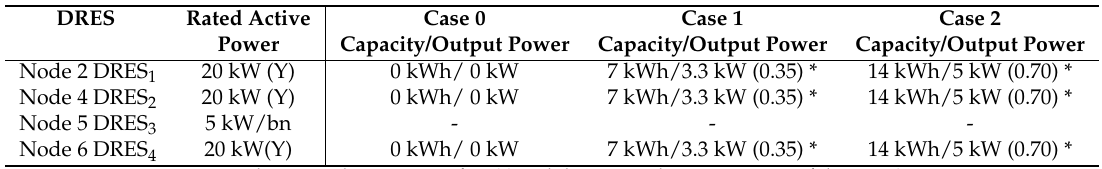
Table 2. Nominal power of DRES and storage capacity.